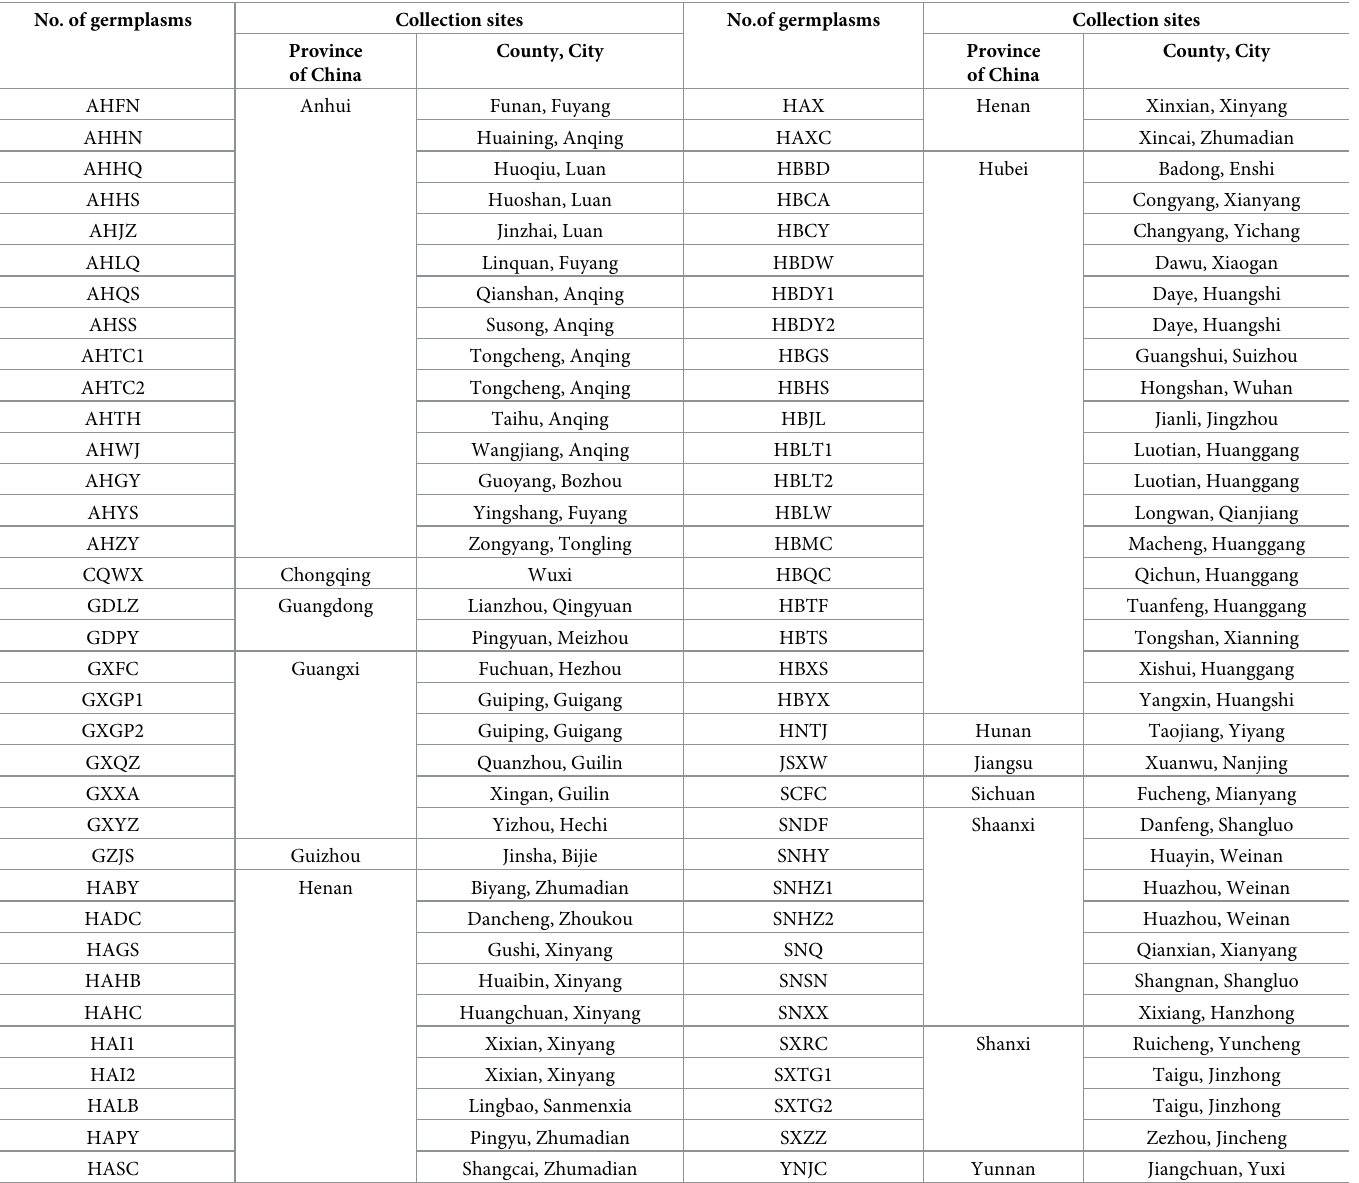
Table 1. Information for C . indicum germplasm collection